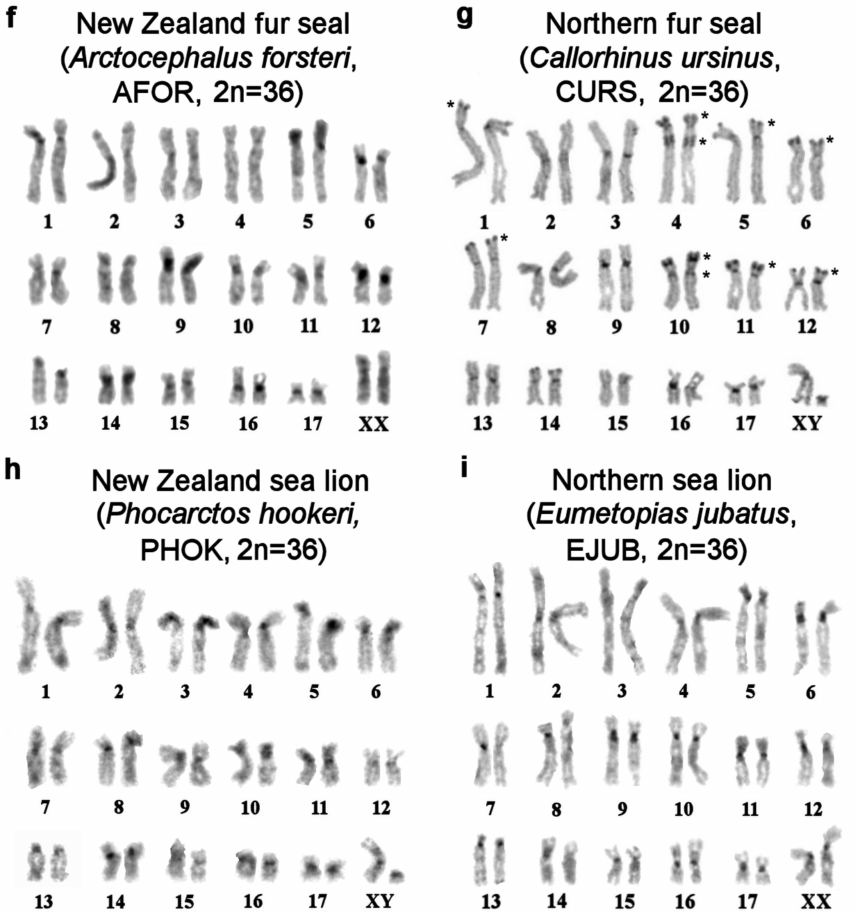
Figure 3. CBG banded karyotypes of ( a ) the walrus and true seals: ( b ) the bearded seal *, ( c ) Baikal seal **, ( d ) ringed seal, and ( e ) harbor seal. For the harbor seal, as is the case for all the species in this article, chromosomes are arranged in descending order. Correspondence to the harbor seal nomenclature of Fronicke et al [8] is given in parentheses. * The C-banding fully matches the one published earlier [20]. Note additional telomeric heterochromatin segments on p-arms of four autosome pairs in EBAR (asterisk). ** Note an intercalary heterochromatin segment in PSIB1p near the region containing rDNA genes (asterisk). CBG banded karyotypes of the eared seals: ( f ) the New Zealand fur seal, ( g ) northern fur seal *, ( h ) New Zealand sea lion, and ( i ) northern sea lion. * Interstitial heterochromatin in CURS1p, CURS 4q, and CURS10q and additional telomeric heterochromatin segments on p-arms are marked by an